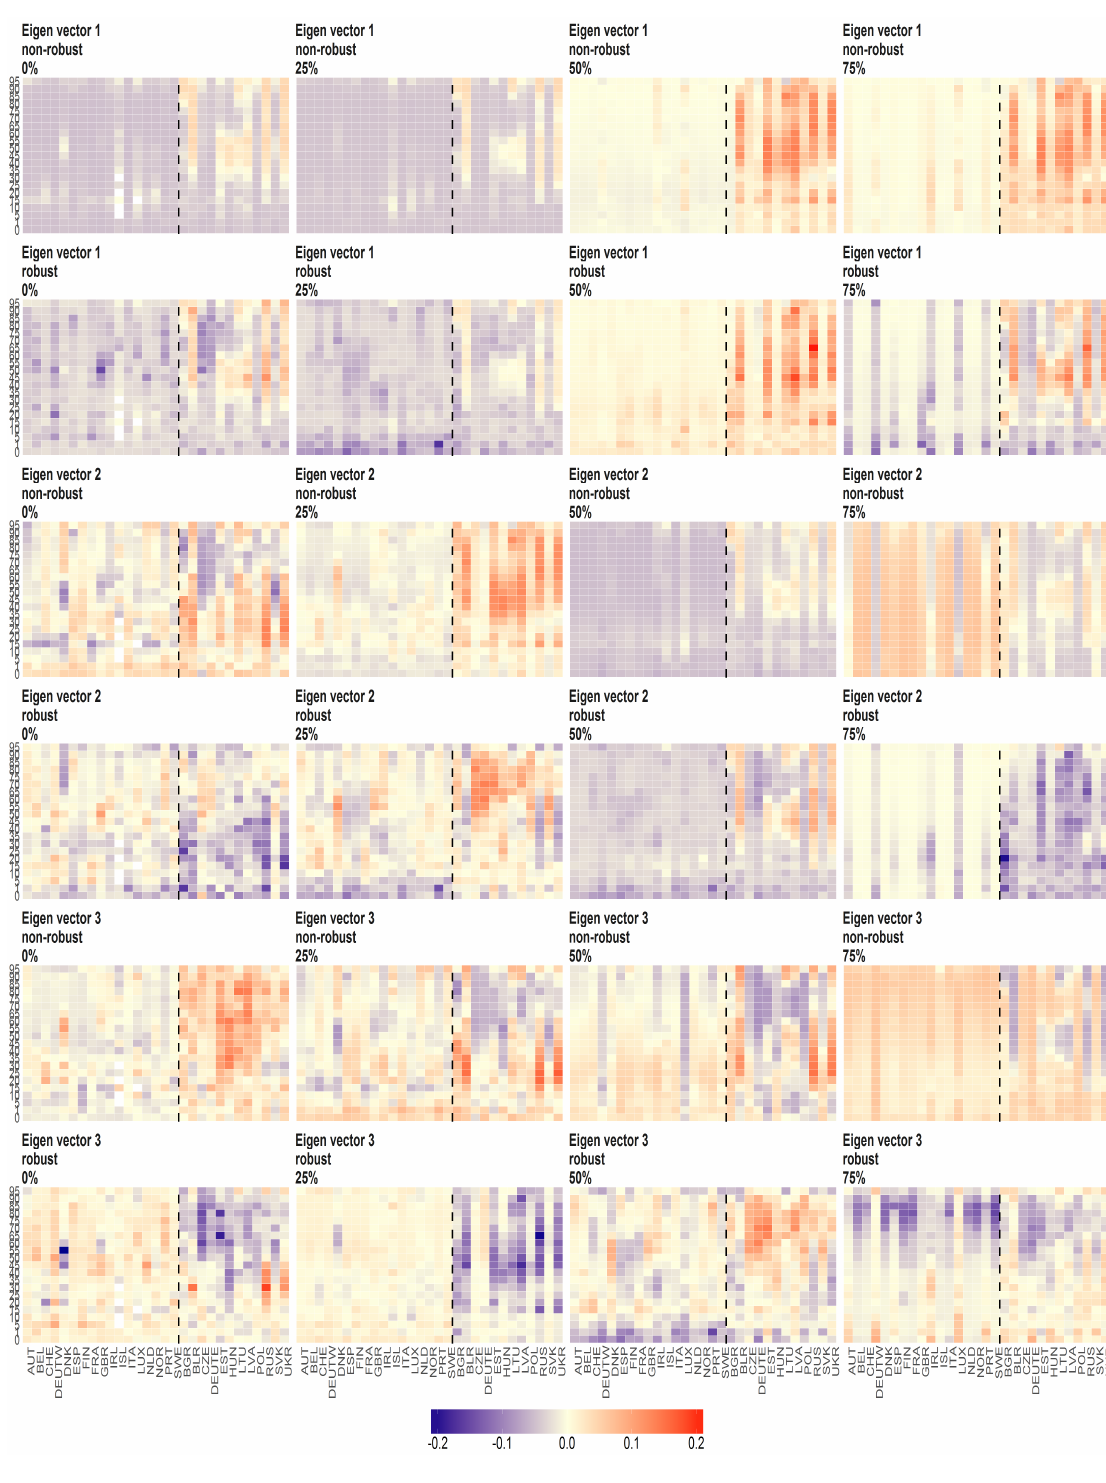
Figure 27. The eigenvectors (y axis) over the joint distribution of countries (x axis) obtained using PPCA for female population of Death Rates. Every row of subfigure corresponds to different eigenvector. Every column corresponds to different level of maximum missing values per observation (0%, 25%, 50% and 75%). The blue line corresponds to robust standardisation whereas red line to non-robust standardisation of